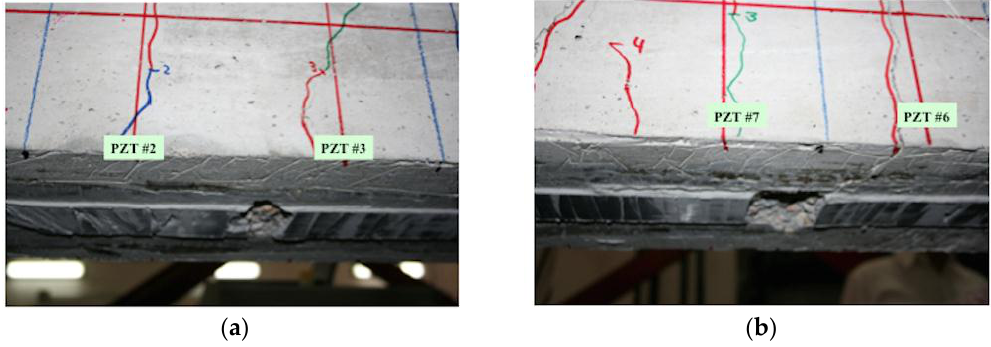
Figure 31. Damages with concrete cover separation between sensors 2 and 3 ( a ) and sensors 6 and 7 ( b ) for the RC beam.